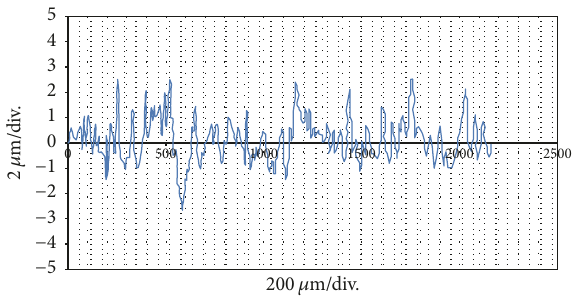
Figure 10: Profile of surface roughness graph by surface roughness tester for machined surface with speed 500 rpm, depth of cut 0.5 mm, and feed rate 50